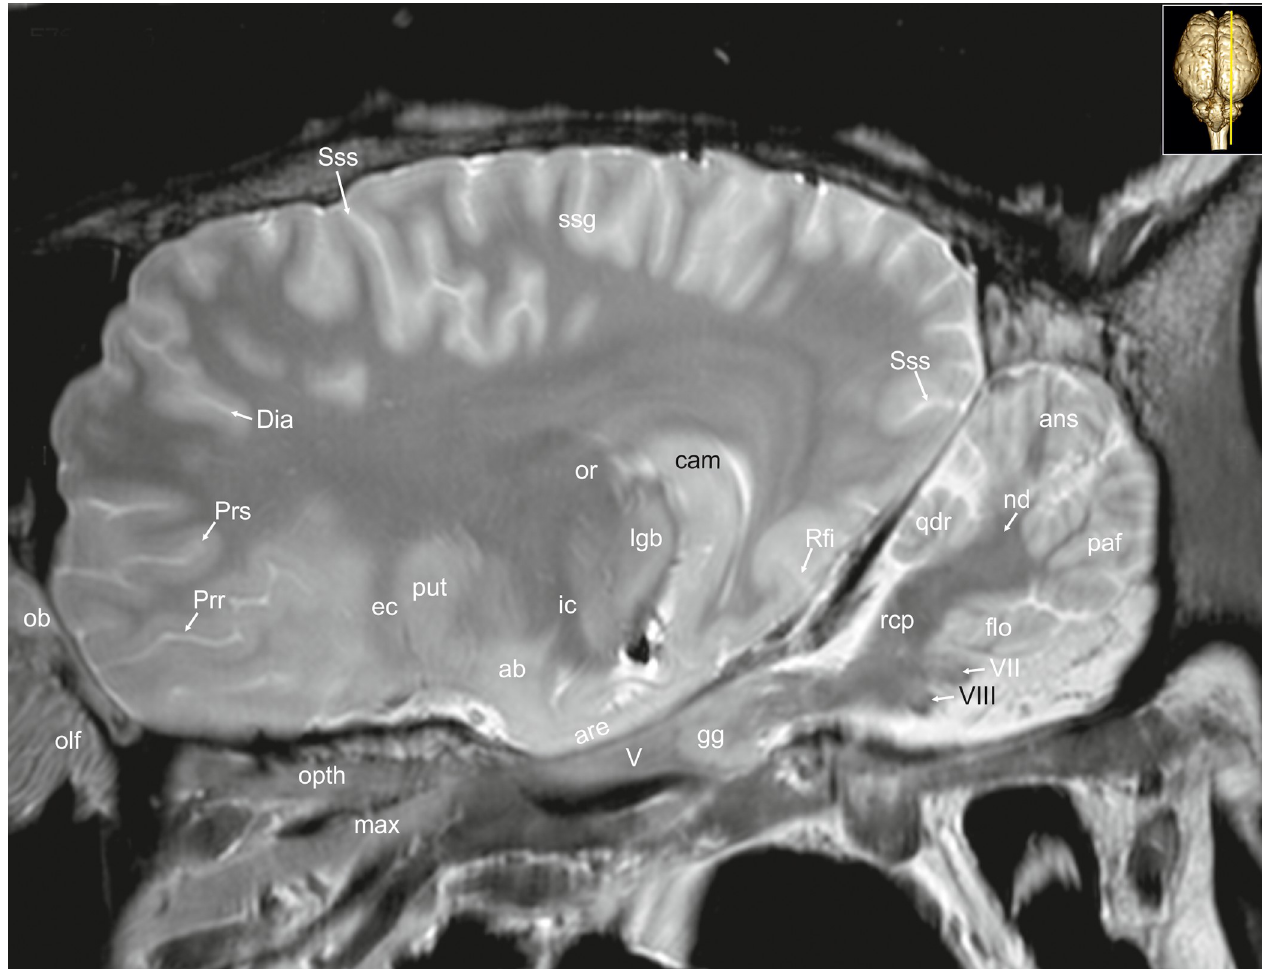
Fig 32. Parasagittal magnetic resonance image of the equine brain at the level of the optic radiation. ab: amygdaloid body, ans: ansiform lobule, are: entorhinal aera, cam: ammon’s horn, chp: choroid plexus, Dia: diagonal sulcus, ec: external capsule, flo: flocculus, gg: Gasserian ganglion, ic: internal capsule, lgb: lateral geniculate body, max: maxillary nerve, mgb: medial geniculate body, nd: dentate nucleus, ob: olfactory bulb, olf: olfactory fibres, opth: ophthalmic nerve, or: optic radiation, paf: paraflocculus, Prr: prorean sulcus, Prs: presylvian sulcus, put: putamen, qdr: quadrangulare lobule, rcp: rostral cerebellar peduncle, Rfi: rhinal fissure, ssg: suprasylvian gyrus, Sss: suprasylvian sulcus, V: trigeminal nerve, VII: facial nerve, VIII: vestibulocochleal nerve.